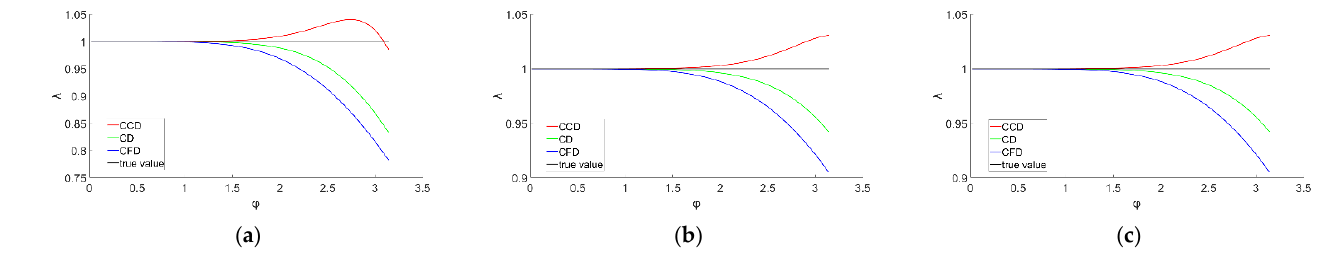
Figure 2. Velocity ratio curves for different numerical simulation methods. The blue curve is the traditional central difference scheme, the green curve is the traditional implicit difference scheme, the red curve is the CCD difference scheme and the black line is the velocity ratio constant of 1: ( a ) θ = 0, α = 0.25; ( b ) θ = π /6, α = 0.25; ( c ) θ = π /3, α = 0.25.